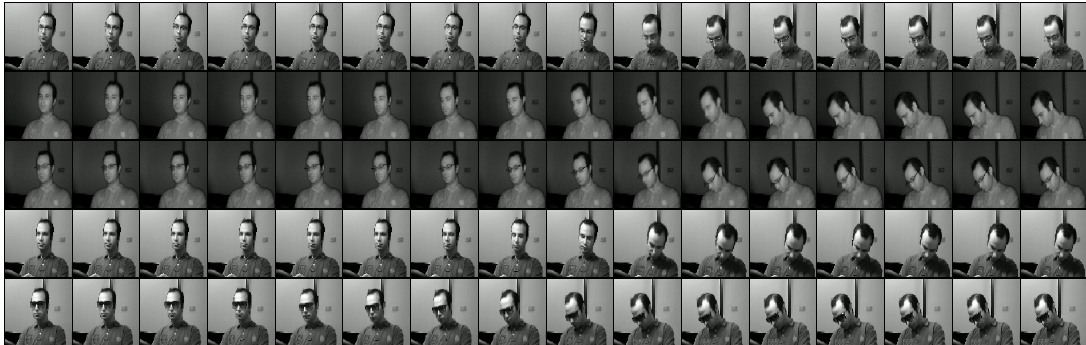
Figure 6. Samples of the two classes, normal and drowsy, of the NTHU-DDD dataset.